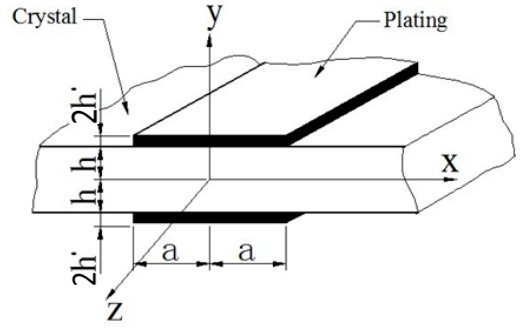
Figure 1. The portion of plated electrodes in an infinite quartz crystal plate.